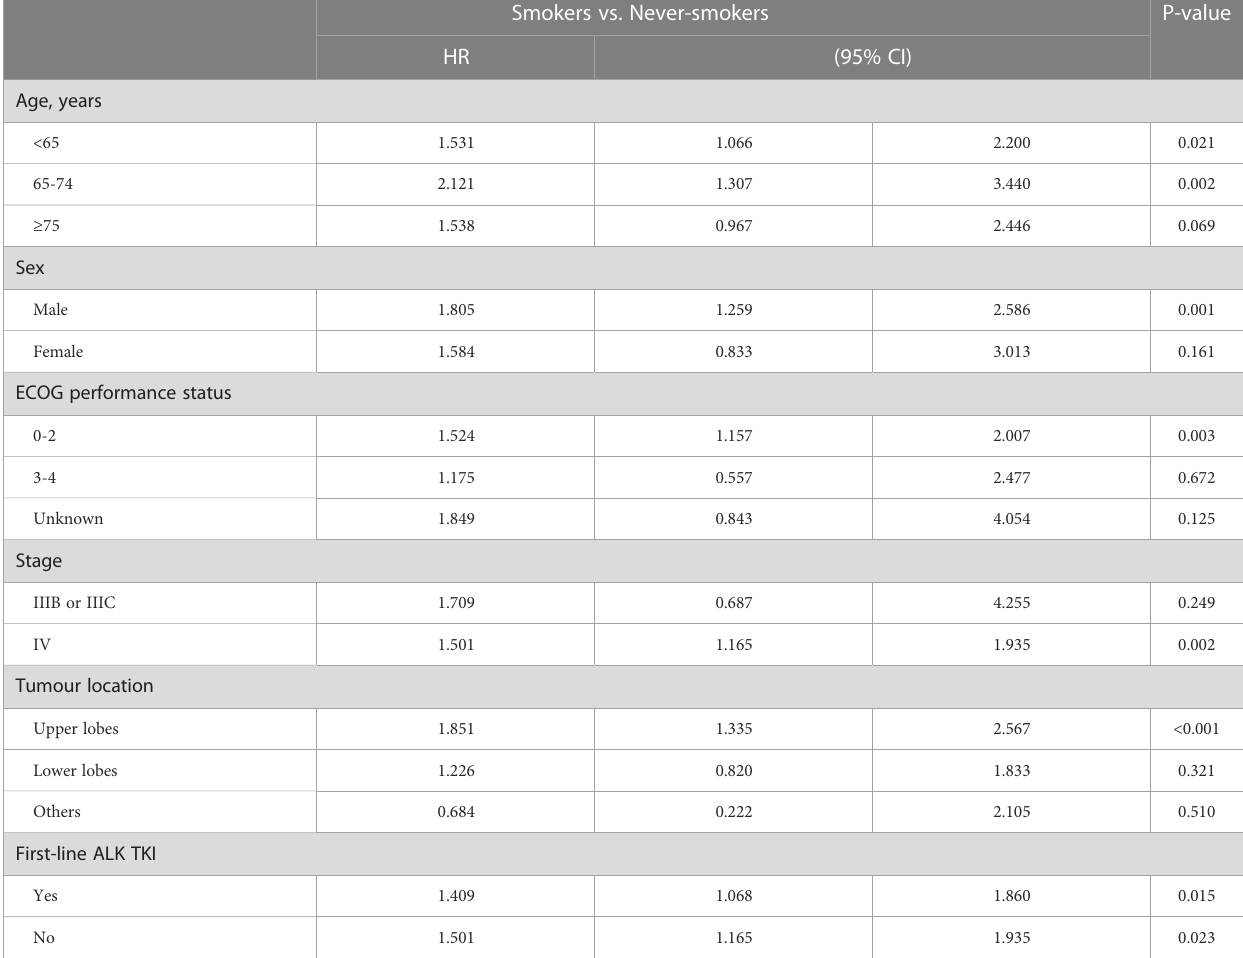
TABLE 3A Univariate analysis of overall survival in different subgroups between smokers and